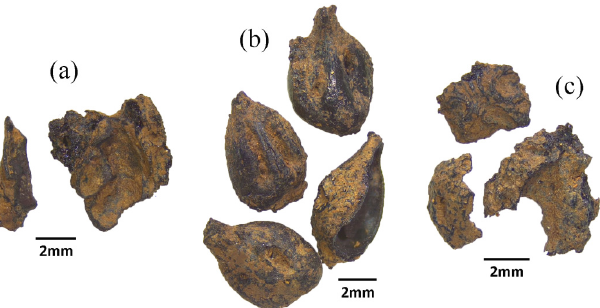
Figure 4. Grape ( Vitis vinifera ) remains from Kophinas: ( a ) pip fragments with fruit pulp; ( b ) whole pips with fruit pulp; ( c ) loose pieces of fruit pulp. On the basis of experimental work (Margaritis and Jones 2006), the grape remains from the pyre could represent either raisins or small fresh grapes. The recovery of olive stone fragments in and around the pyre could suggest that this fruit also featured as part of the plant sacrifice, though the number of these remains is low, and they could equally result from feasting activities. Both grape and olive, however, likely grew within the rel- ative vicinity of Kophinas, and it is interesting to consider whether these fruits comprise deliberately selected plants for the sacrifice or fruits of opportunity. Certainly, as deliber- ately selected plants, both grape and olive would have held a symbolic significance to the Minoans during the Neopalatial period, since they represented the social and economic lifeblood of the culture through their extensive exploitation as cash crops for the produc- tion of olive oil and wine. The recovery of herbaceous seeds belonging to the Lamiaceae family suggests that plants with aromatic properties were also burned on the pyre, perhaps for the purpose of creating a fragrant atmosphere that activated the olfactory faculties of spectators. When considering the activities at Kophinas from the perspective of the archaeology of the senses, all five of the audience’s senses may have been stimulated during ritual events. The heat generated by the pyre, the vision of burning plant sacrifices and the noise that accompanied them probably acted as tactile, visual and auditory stimuli. Additionally, if the consumption of food and drink accompanied the ritual practices, as the ceramic as- semblage suggests, then this would have also triggered the guests’ sense of taste. The sim- ultaneous activation of all the senses during the sacrificial event would have made for an impactful performance that created a powerful memory of this socioreligious experience. The bulk of the archaeobotanical material recovered at Knossos Anetaki came from samples collected in the West half of the Main Chamber of the Fetish Shrine, between the central altar and the bench with the fetish idols. This same area produced several intact conical cups and kalathoi —Minoan cultic vessels used for the purpose of making offerings (Day 2009; Evans 1964; Tsipopoulou 2009). While these vessels did not contain any finds at the time of excavation, their over-turned, in situ position indicates that their original contents may have been the plant remains and that these were spilled out onto the floor prior to deposition.